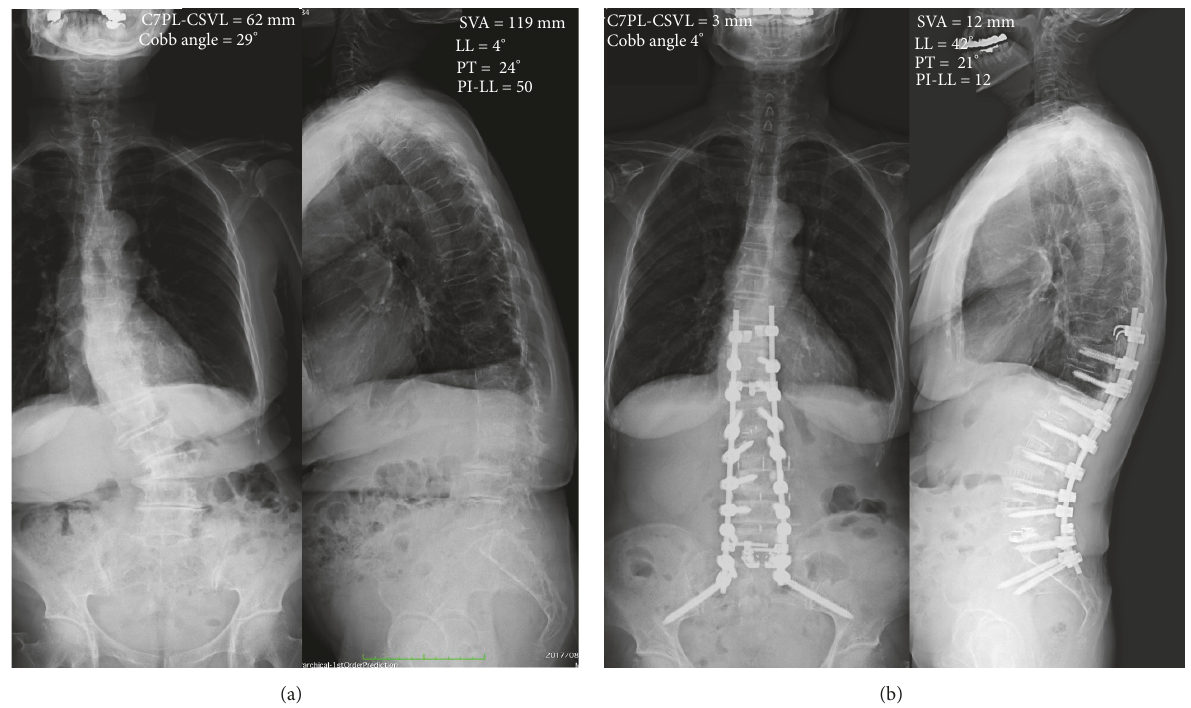
Figure 5: Before and after images of total spine of the case. The after images were 1 month after the